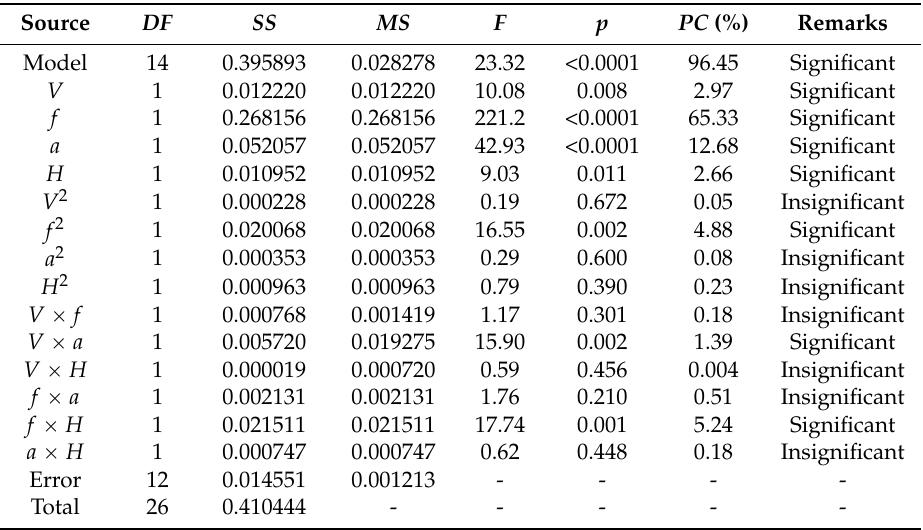
Table 5. Analysis of variance for Ra .